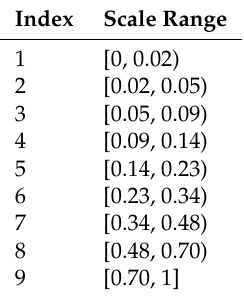
Table 1. Nine indices with the corresponding scale